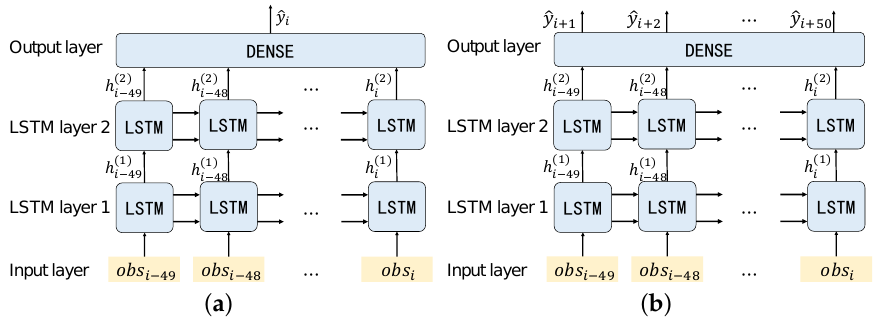
Figure 3. LSTM models structure: ( a ) the driving intention and lane change time prediction models. ( b ) The vehicle trajectories prediction models.